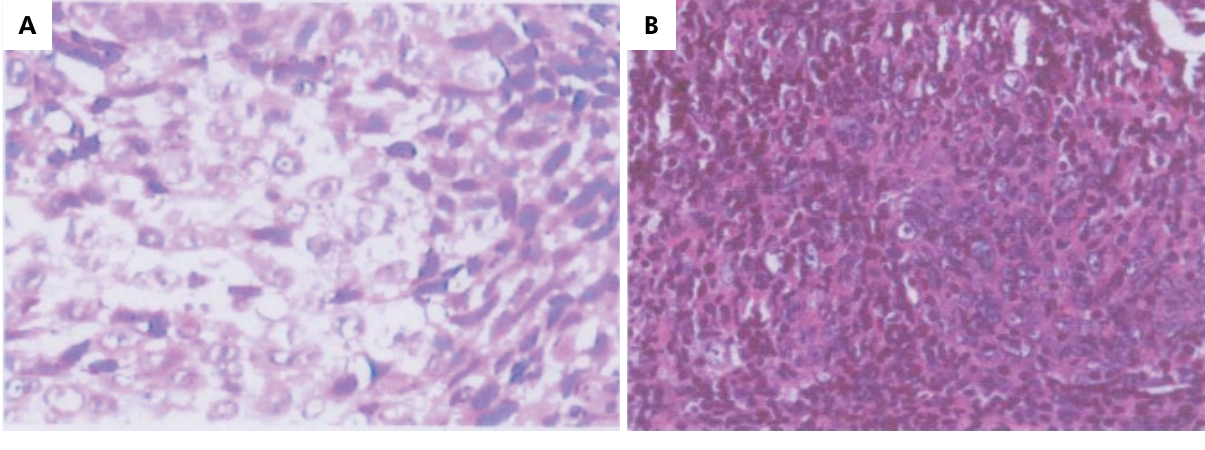
Figure 1. Histological examination of (A) undifferentiated carcinoma (WHO type 3) and (B) non-keratinizing squamous cell carcinoma (WHO type